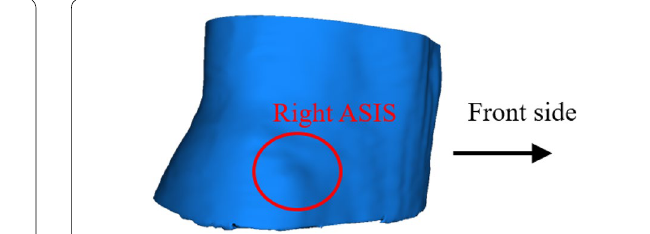
Fig. 5 Example of human shape (pelvis) [24]